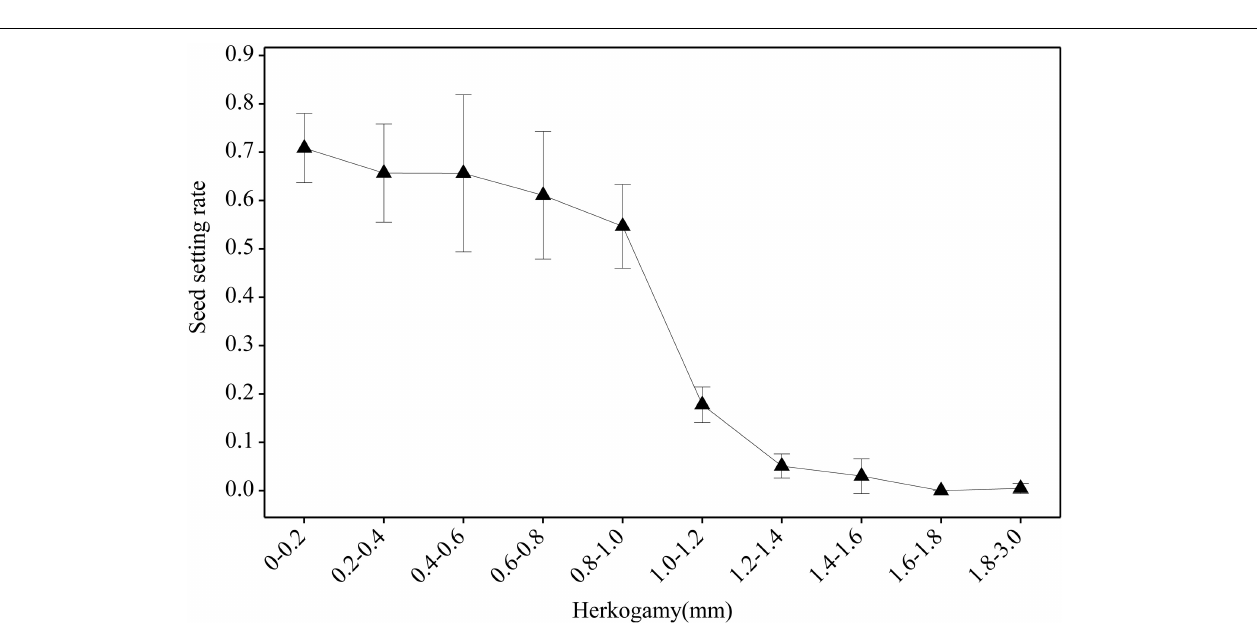
FIGURE 8 | Effect of herkogamy on the seed setting rate of P. wannanensis plants covered with a net to exclude effective pollinators. The X-axis indicates the herkogamy value, and the Y-axis indicates the average seed setting rate. Error bars indicate a 95% confidence